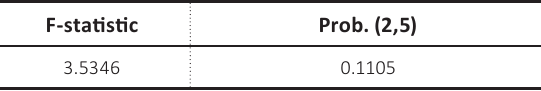
Table 7. Breusch-Godfrey serial correlation LM test